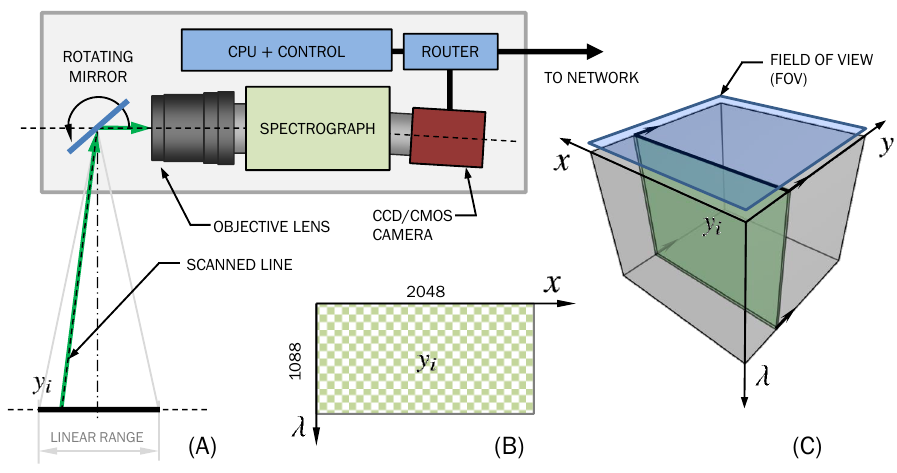
Figure 1. A generalized description of an external rotating mirror scanning imaging system. ( A ) A single focused line within the field of view can be captured at a time; ( B ) each line will consist of a two-dimensional sensor measurement, where the first axis will represent spatial dimension x , and the second one specifies wavelength, λ . ( C ) A complete hyperspectral image is obtained by moving the rotating mirror and storing more images for each of the mirror’s positions ( y